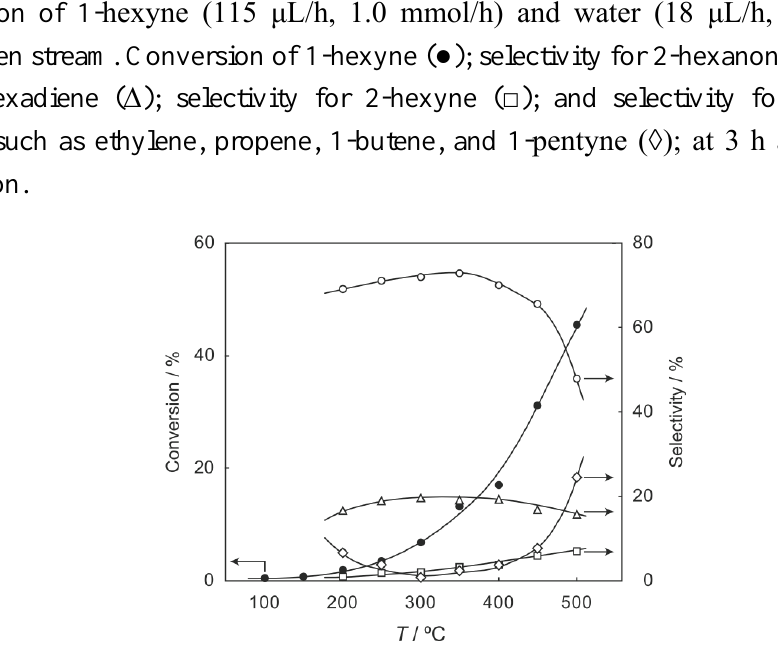
Figure 32. Effect of temperature on the reaction of 1-hexyne with water over (H O) [(W Cl )Cl ]·6H O/SiO in a nitrogen stream. Following activation of the 3 2 6 8 6 2 2